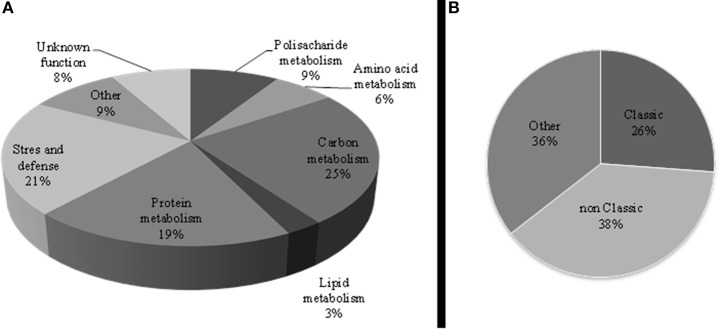
(A) Functional classification of the non-redundant leaf apoplastic proteome of sugar beet. Pathways related to the identified proteins were integrated according to the GO annotation. (B) Protein distribution of the non-redundant leaf apoplastic proteome according to TargetP and SecretomeP algorithms; CS and nCS indicate classical and non-classical secretory proteins, respectively, whereas “Other” represents proteins ascribed to other cellular compartments and unclassified.